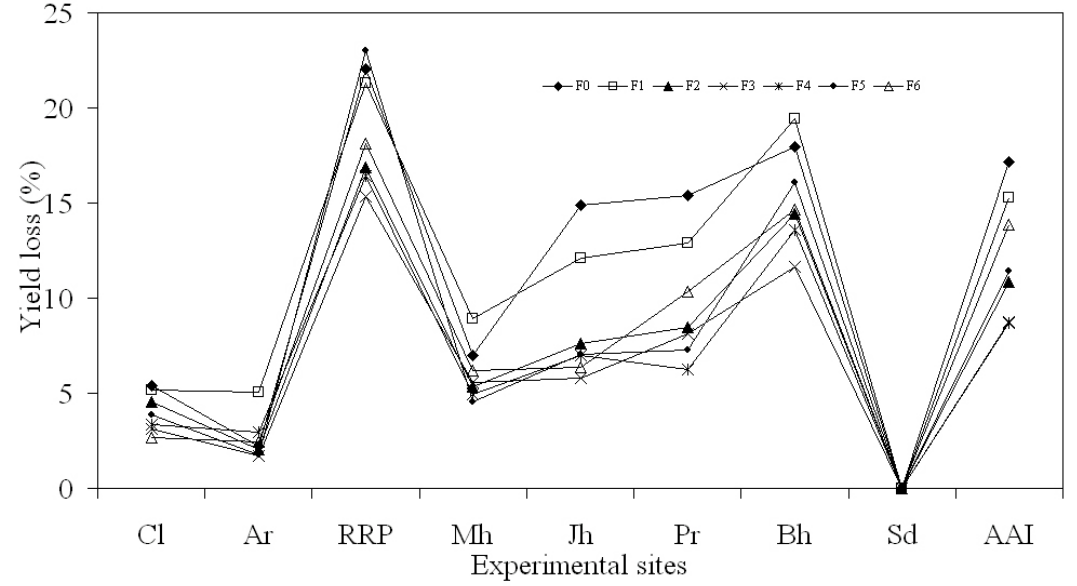
FIGURE 6. Effect of different fertility levels on yield loss against Sd (reference site) of wheat plants grown at various